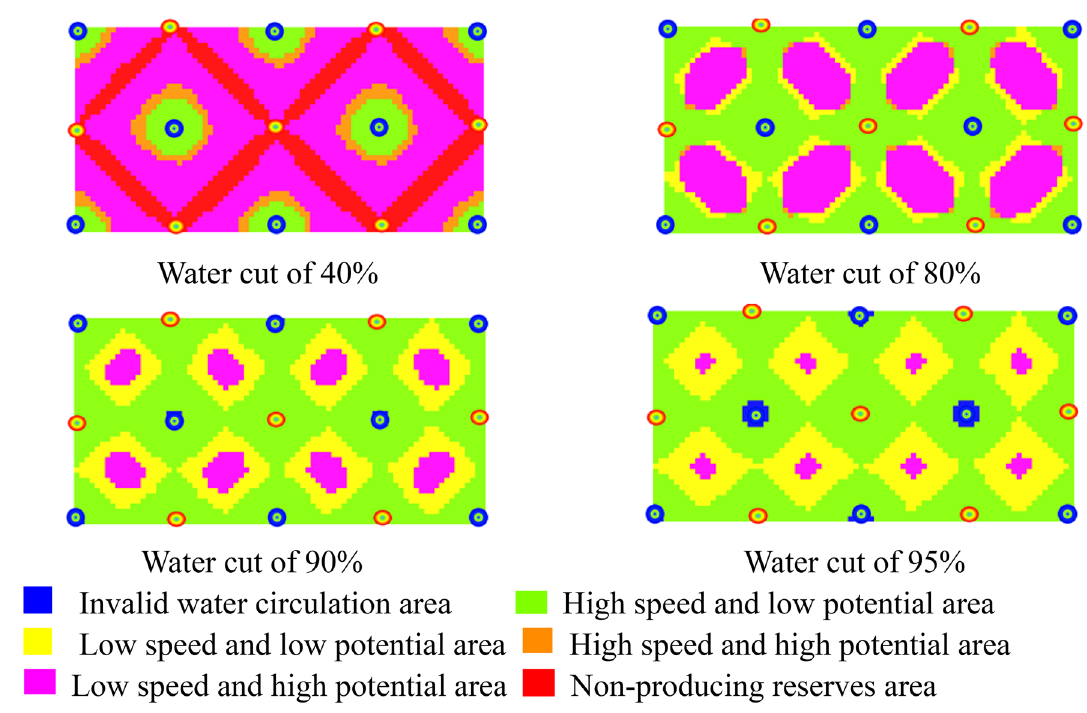
Fig. 6 Seepage field partition diagram of five spot pattern